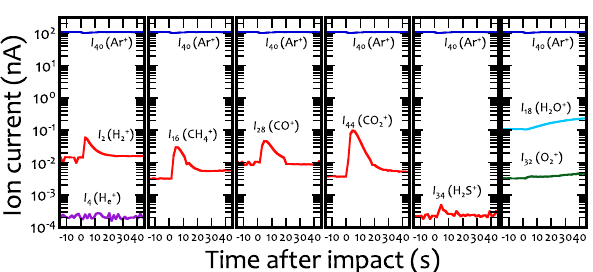
Fig. 1 Mass spectrometry data for the generated gas species. The graphs show the temporal variation of the ion currents for gases with the mass numbers I i for shot #448 (high v imp ). The time variations for the ion counts can be found in Supplementary Data